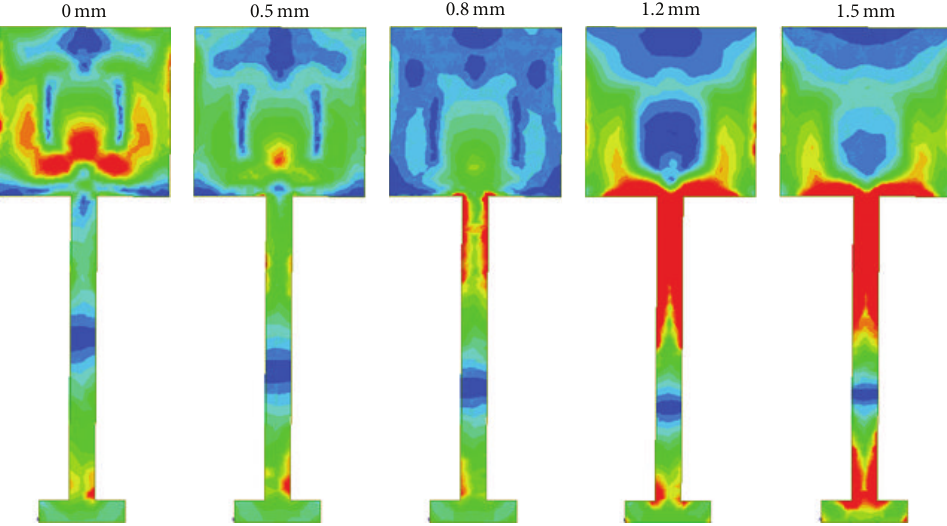
Figure 24: Current distribution on the miniaturized patch antenna on different location of CSRR